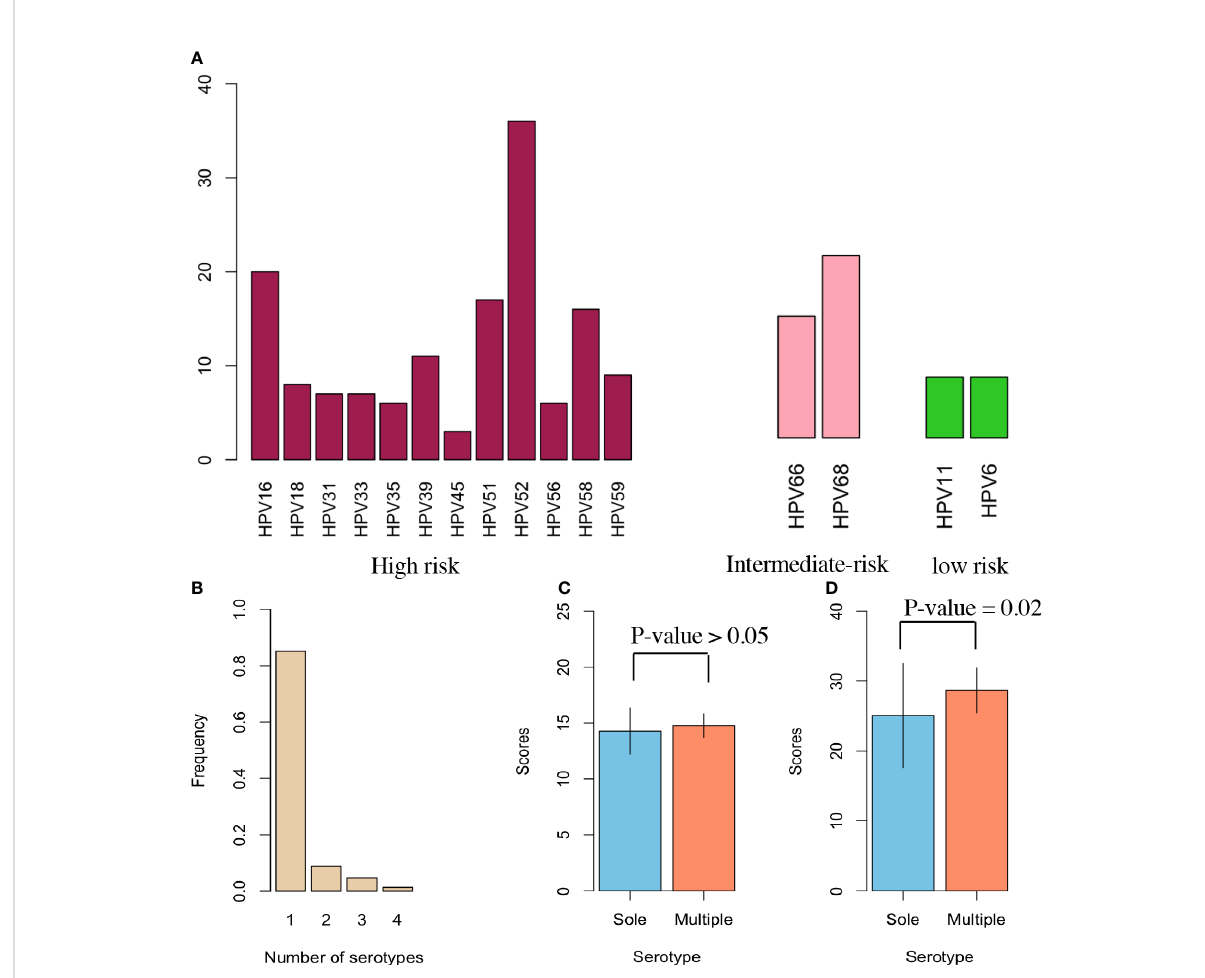
FIGURE 1 HPV Serotypes in participants. (A) Each HPV serotype ’ s prevalence involved 12 high-risk HPV (hrHPV), 2 intermediate-risk HPV (irHPV), and 2 low- risk HPV (lrHPV). All identi fi able serotypes were denoted at the x-axis, and their proportions as percentages were designated at the y-axis among all HPV-infected women. The left red columns indicate the prevalence of each serotype for the 12 hrHPV; the middle pink columns the prevalence of each serotype for the 2 irHPV; the right green columns the prevalence of each serotype for the 2 lrHPV. (B) This panel shows the number of serotypes identi fi ed for each patient infected with HPV. (C) Physical activity risk in two categories of data with sole and multiple serotypes in a bar chart. This plot displays the scores along with mean and SD without illustrating effect size. (D) Similar bar chart as (C) , but with diet balance